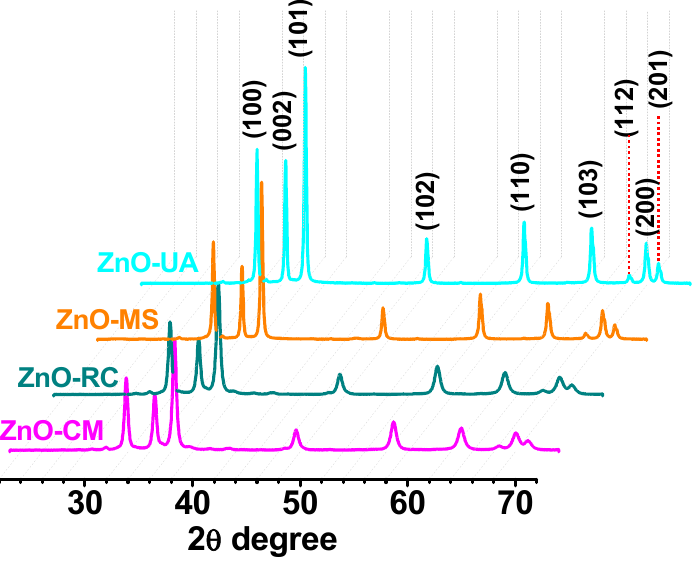
Figure 2. X-ray diffractograms of the ZnO samples synthesized at different conditions. The particle size of the ZnO nanoparticles was measured by dynamic light scattering (DLS), which revealed that they were all strongly scattering samples. Then they were analyzed with a measurement angle of 175 ◦ . The particle size distribution is plotted in Figure 3 with their calculated hydrodynamic diameter (HD) and polydispersity index (PDI). Here, one element that stands out from Figure 3 is related to the number of peaks from the size distribution plot. The ZnO-UA and ZnO-MS samples show only one size distribution. The ZnO-UA peak is centered at 1695 nm, has an HD of 2950 nm, and a PDI of 18%. The ZnO-MS peak is centered at 1606 nm, with an HD of 2591 nm and 12% PDI. On the other hand, ZnO-RC and ZnO-NS present two. ZnO-RC has one centered at 183 nm and the other at 1659 nm, and ZnO-NS has one centered at 107 nm and the other at 1416 nm. Additionally, their HD is 2721 nm and 2299.91 nm, while their PDI is 27% and 29%, respectively. Those parameters suggest that the samples may have different agglomeration states. Also, the motion state affects the kinetic of the synthesis and, consequently, changes in their